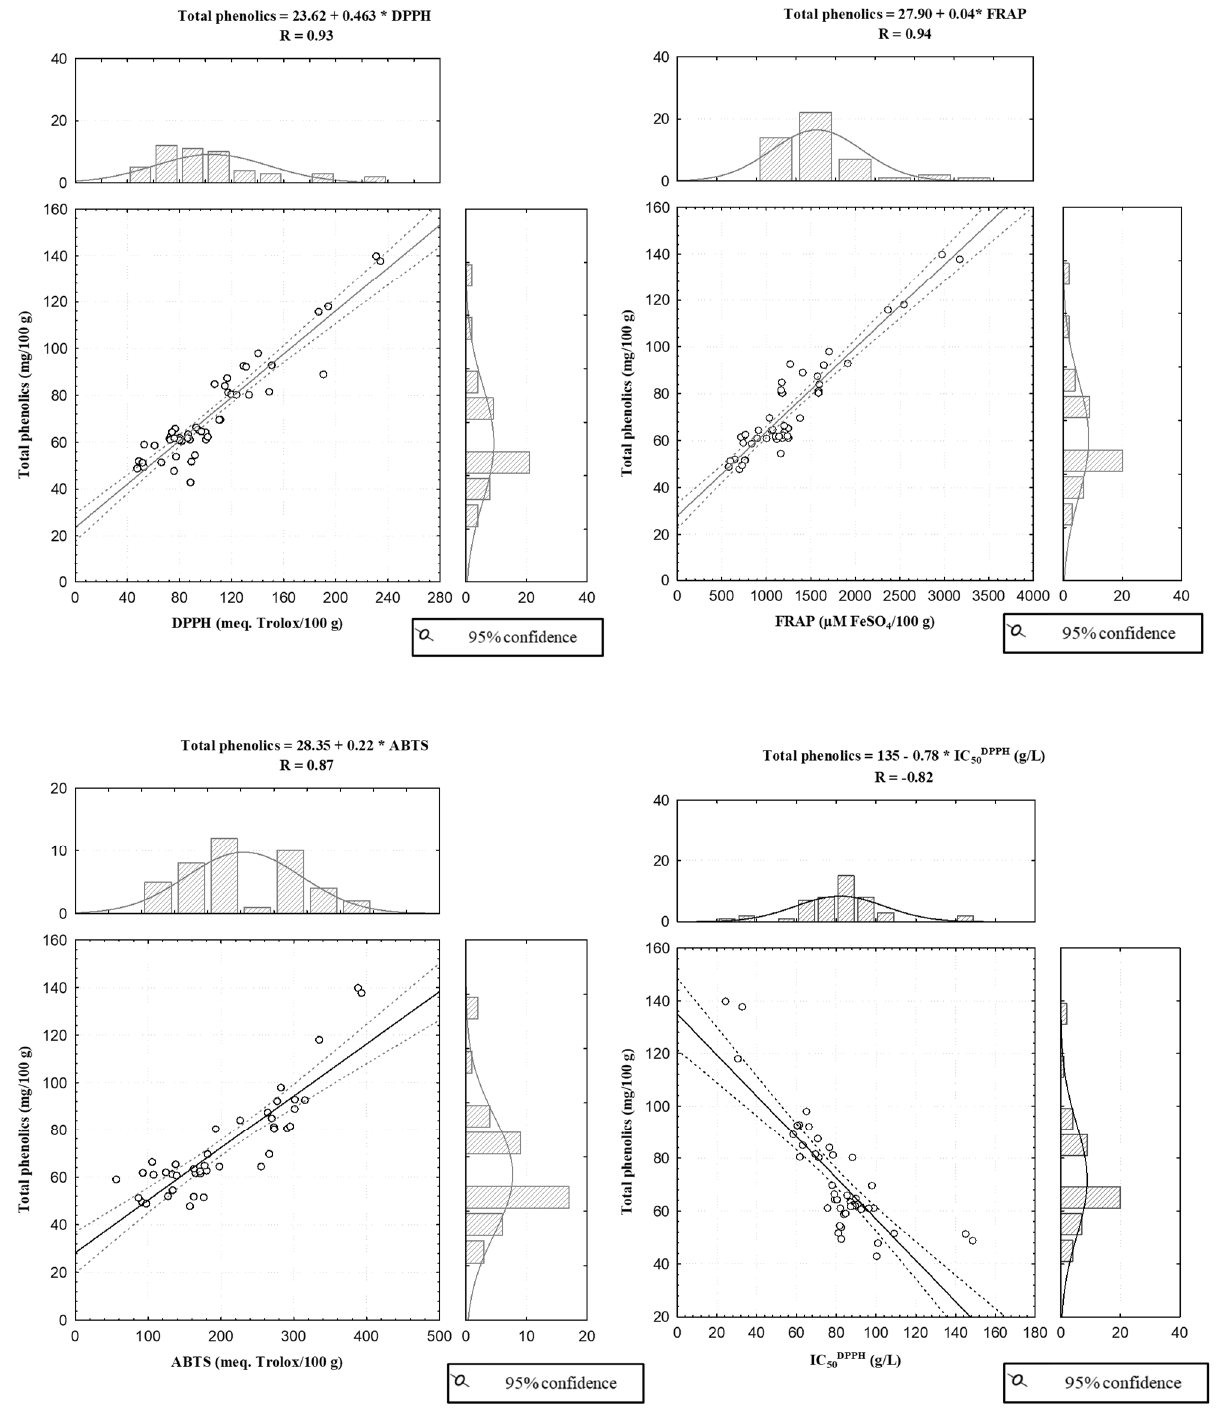
Figure 2. Correlations established among total phenolic content, results of the antioxidant assays and IC 50DPPH values of the chestnut samples.